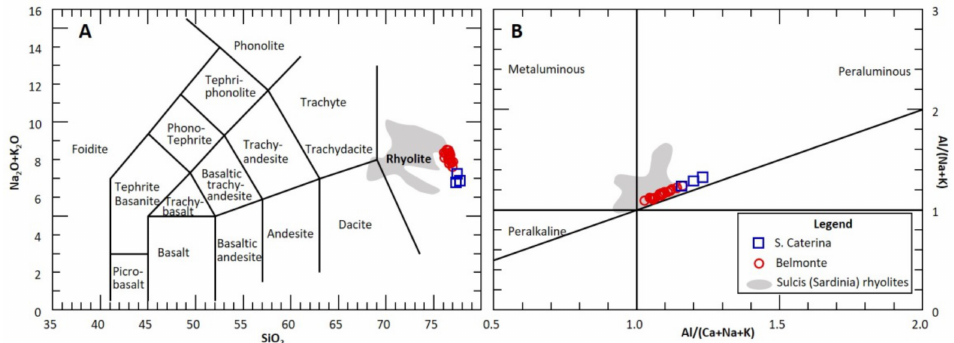
Figure 9. ( A ) TAS diagram [76] and ( B ) Shand’s index [77] of volcanic glass fragments of BE (red circle) and SC (blue square) outcrops, compared to Sardinian products of late Oligo-Miocenic volcanism of Sulcis area (grey area)